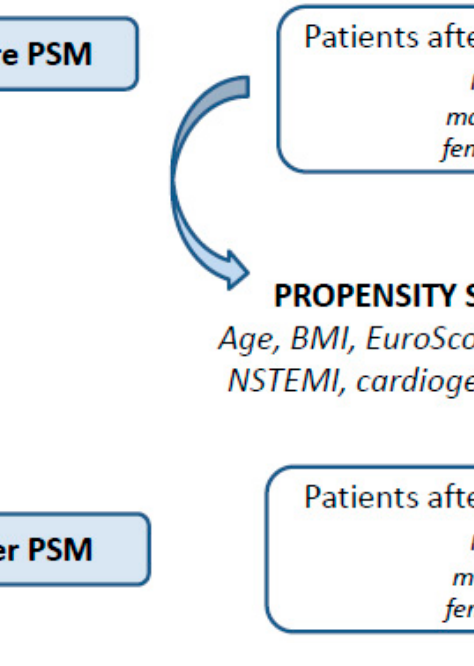
Figure 1. Study groups after OPCAB surgery before and after PSM. OPCAB: off-pump coronary artery bypass grafting. PSM: propensity score matching. CKD: chronic kidney disease. BMI: body mass index. STEMI: ST-elevation myocardial infarction. STEMI: non-ST-elevation myocardial infarction. LV-EF: left ventricular ejection fraction.